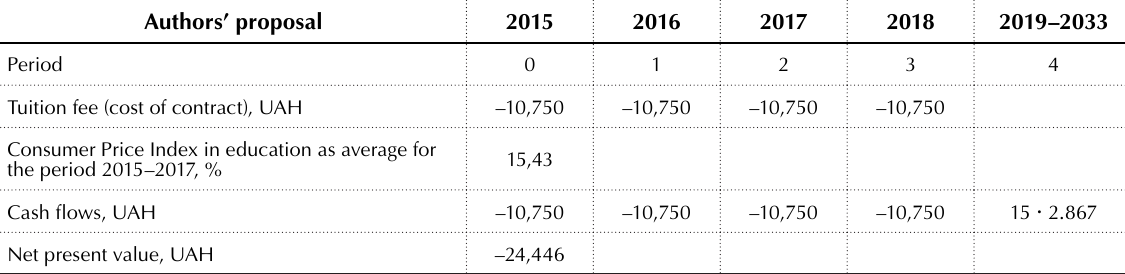
Table 4. The cost of education per a single bachelor student if target state preferential loan is